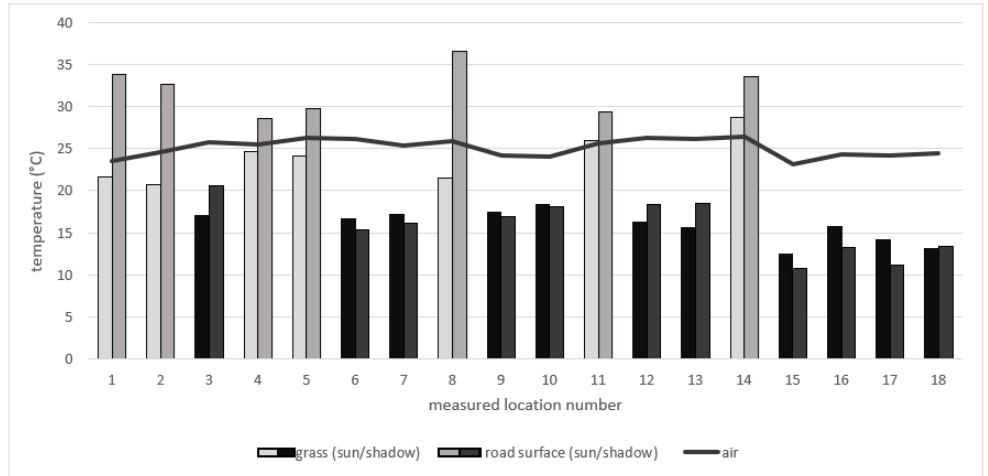
Figure 5. Temperature comparison of all measured locations and grass locations with the air temperature at 12 noon on 18th August 2019 (light green/grey — sunlight, dark green/grey — shadow).